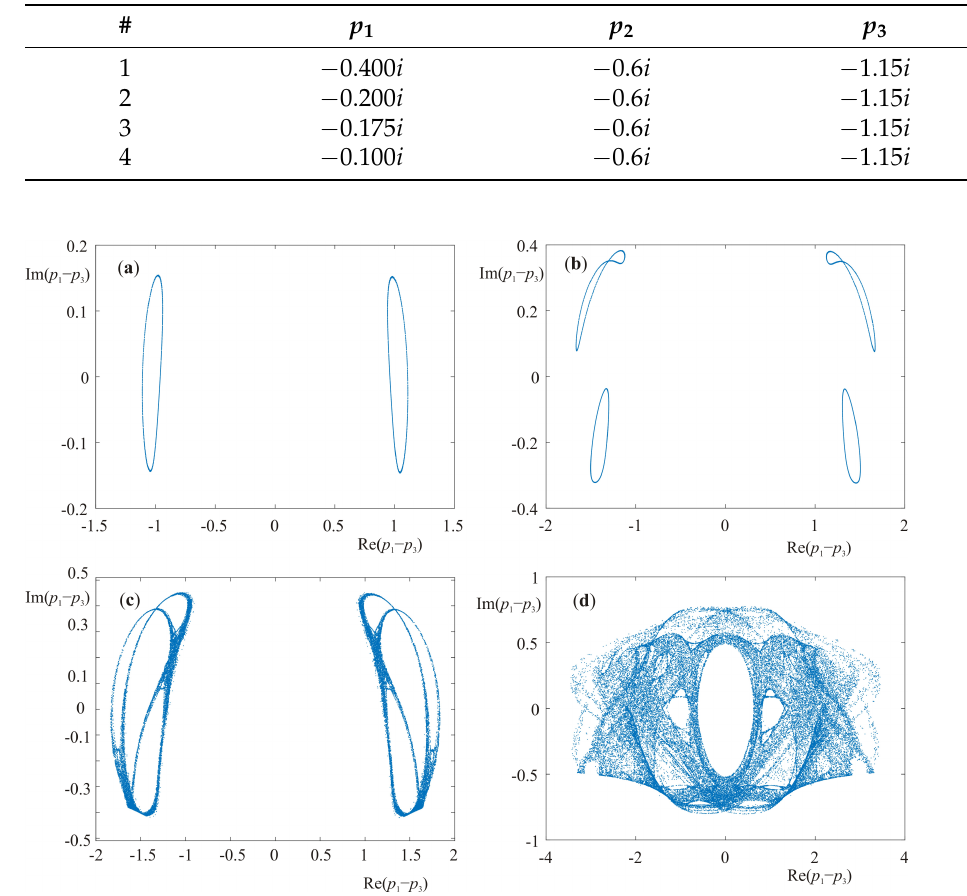
Table 1. The initial poles positions for the numerical solution of the system (8).